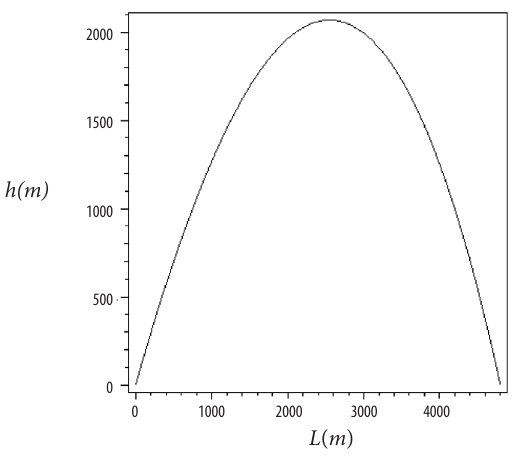
Fig. 5. Flight trajectory of mortar mine ( L = 4800 m)